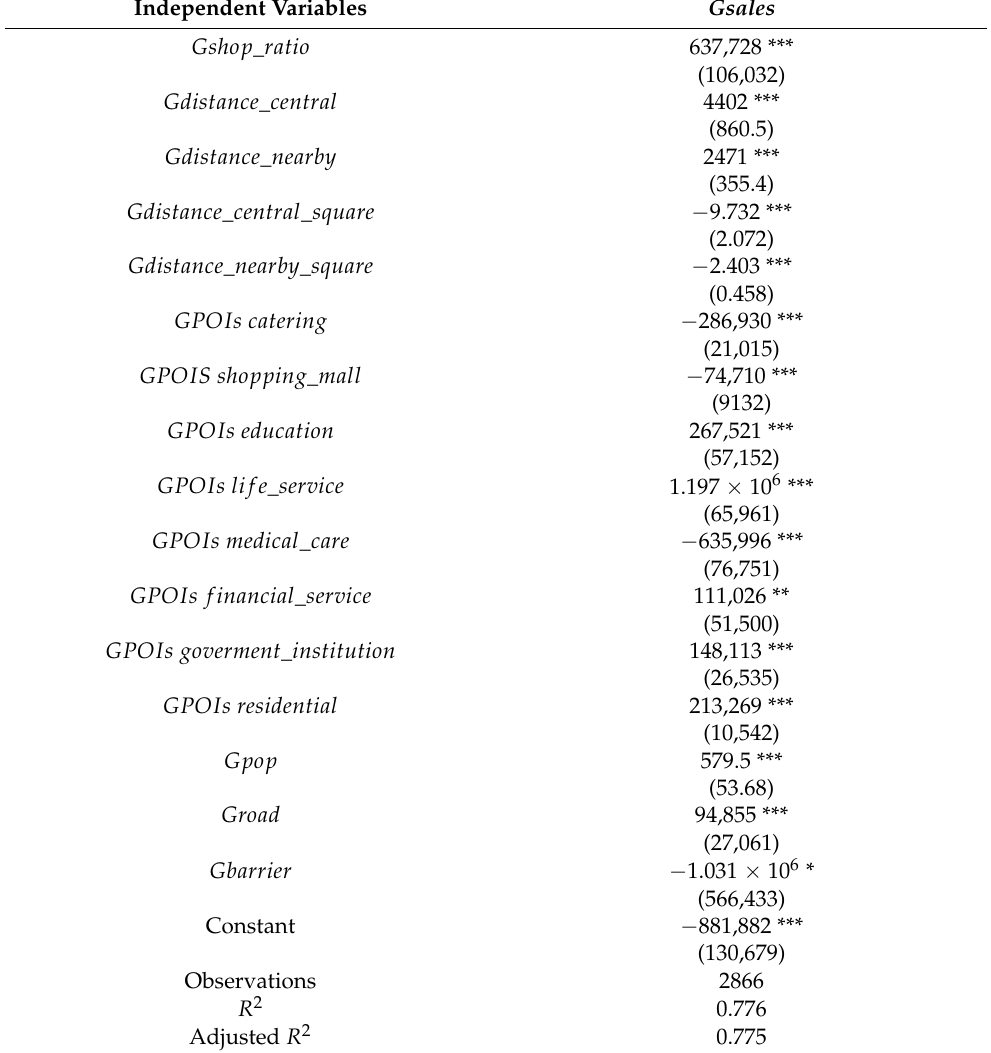
Table 5. Regression results of squared distance metrics on sales